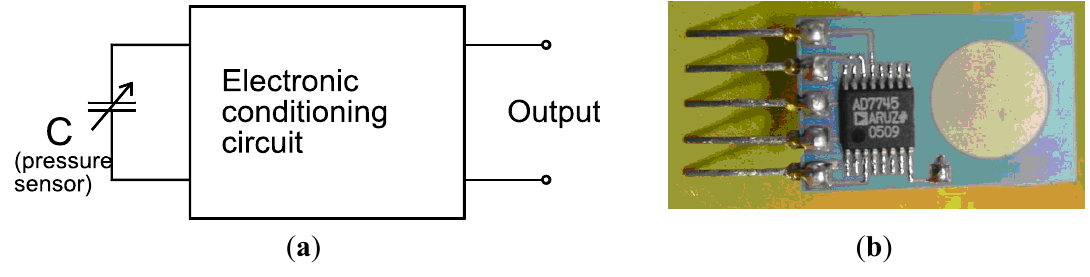
Figure 6. The capacitive sensing element integrated with the electronic conditioning circuit: ( a ) block diagram; ( b ) prototype with surface mounted signal conditioning